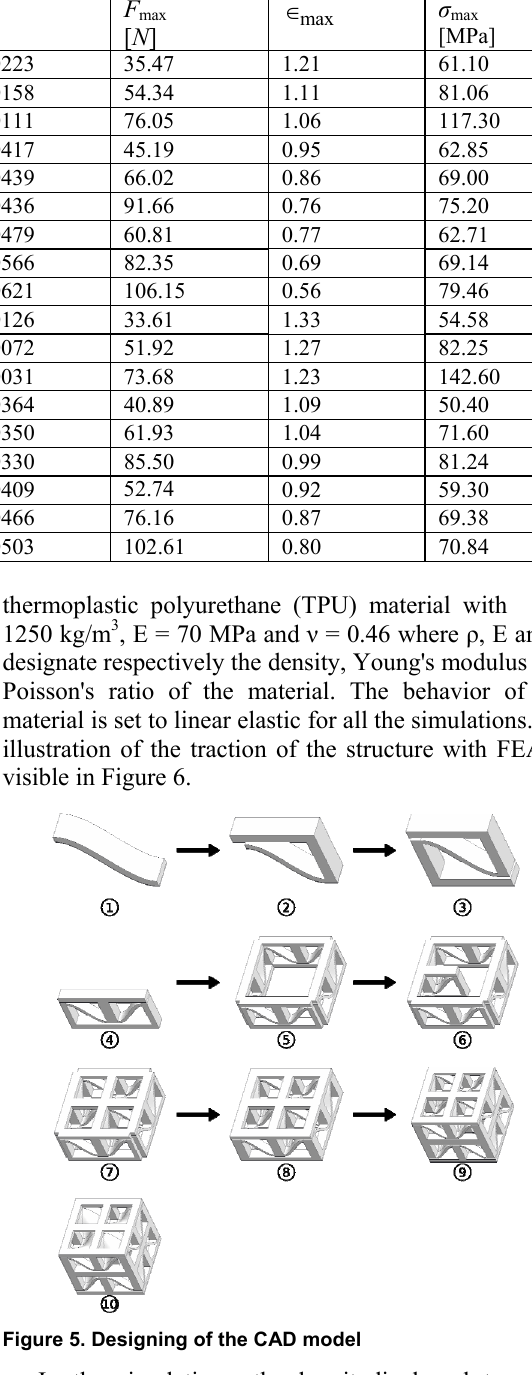
Table 1. Design of experiments Geometrical parameters Evaluation parameters Simulation